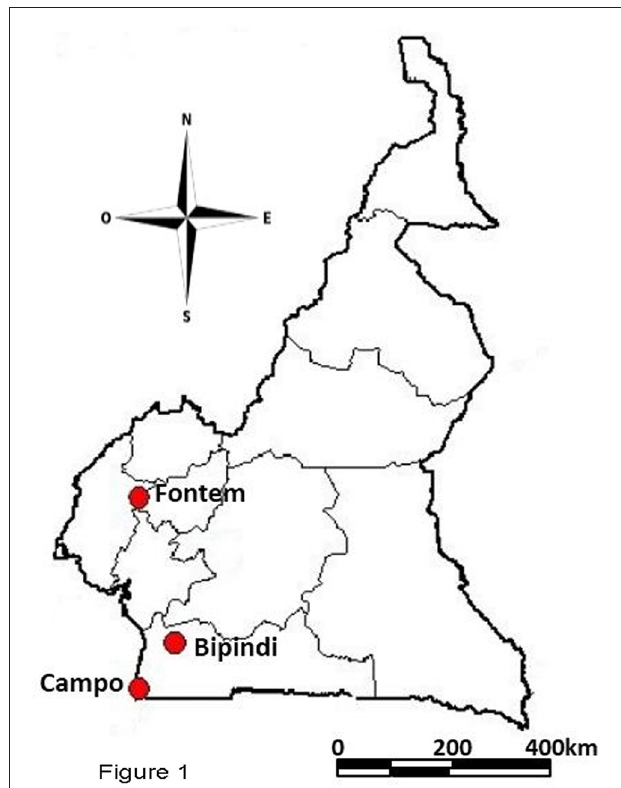
FIGURE 1 | Geographical map showing the three described Cameroonian HAT